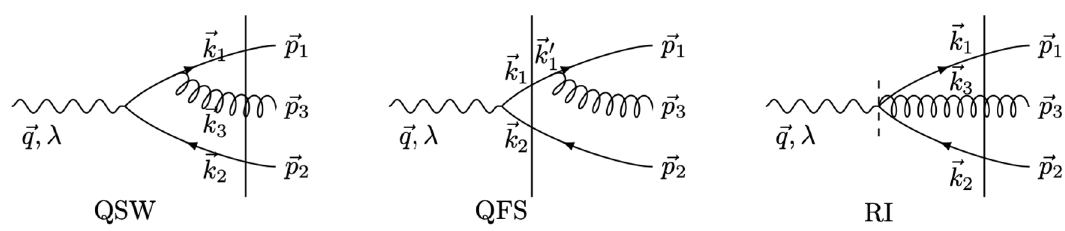
Figure 3 . QSW : real gluon emission from the quark, scattering off the shockwave (vertical full line). QFS : gluon radiated from the quark in the final state. RI : instantaneously created real gluon scatters off